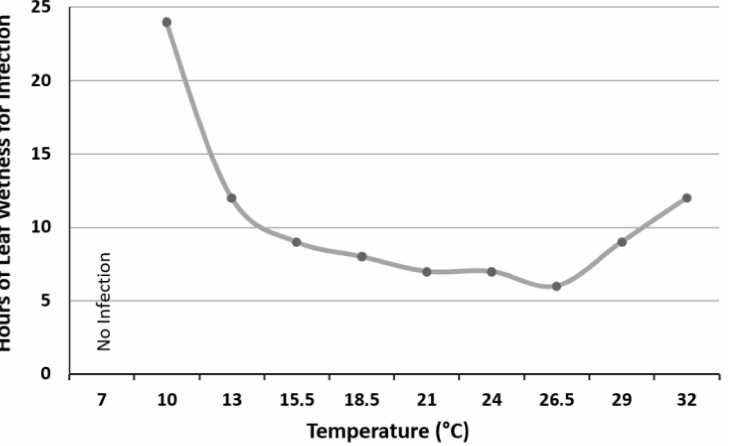
Figure 2. Duration of continuous leaf wetness necessary for infection by the black rot fungus at different temperatures